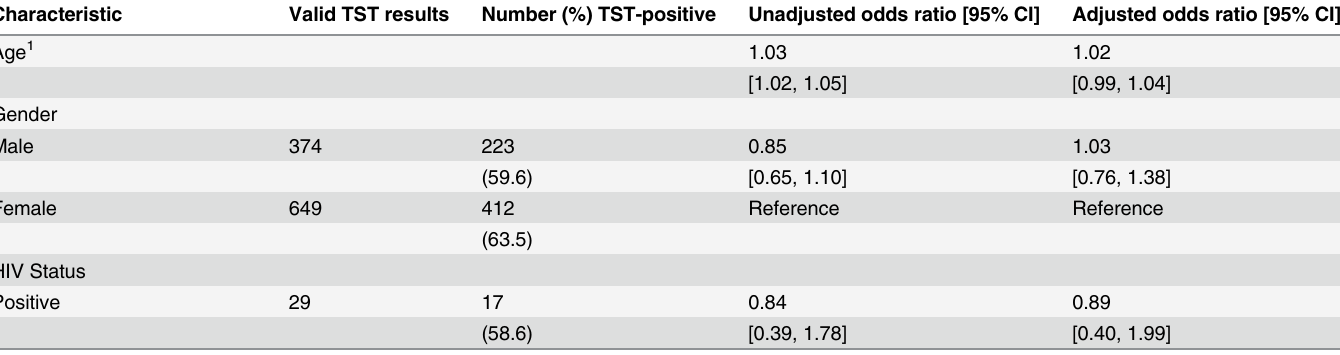
Table 4. Associations between latent TB infection, as identified by TST results, and presumptive risk factors for health facility workers from Kigali, Rwanda.